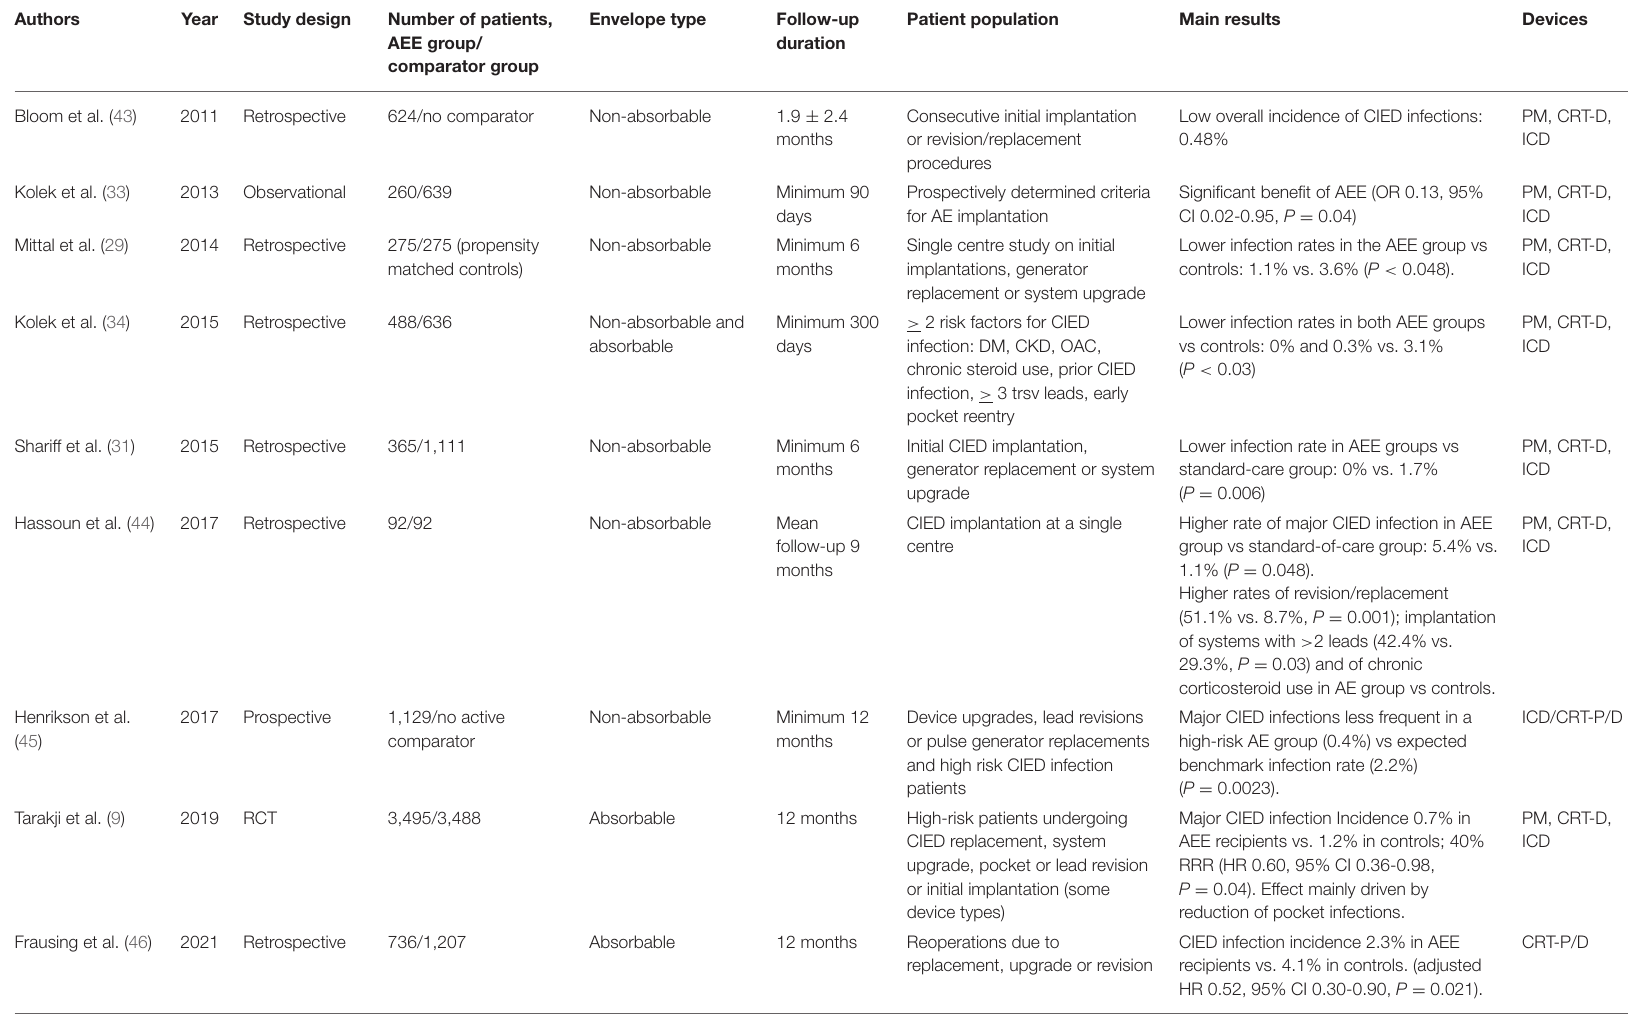
TABLE 2 | Summary of the studies on efficacy of antibiotic-eluting